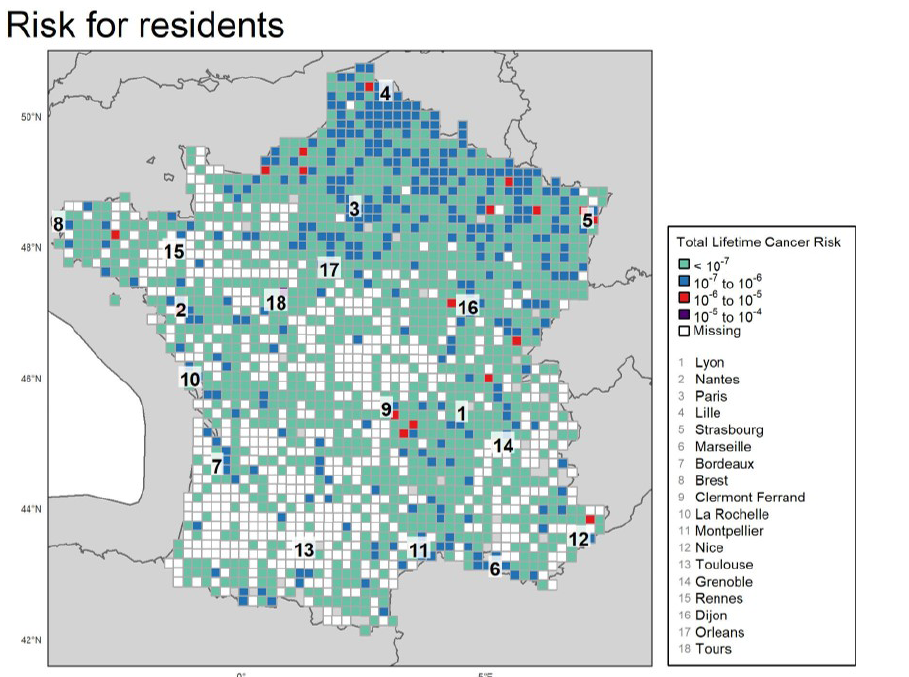
Figure 3. Health risk assessment for the residential population, showing the total lifetime cancer risk (TLCR) for French soils, along with the location of major cities. Missing values correspond to sites at which no PAHs were quantified, so a TLCR below 10 − 7 can be assumed.